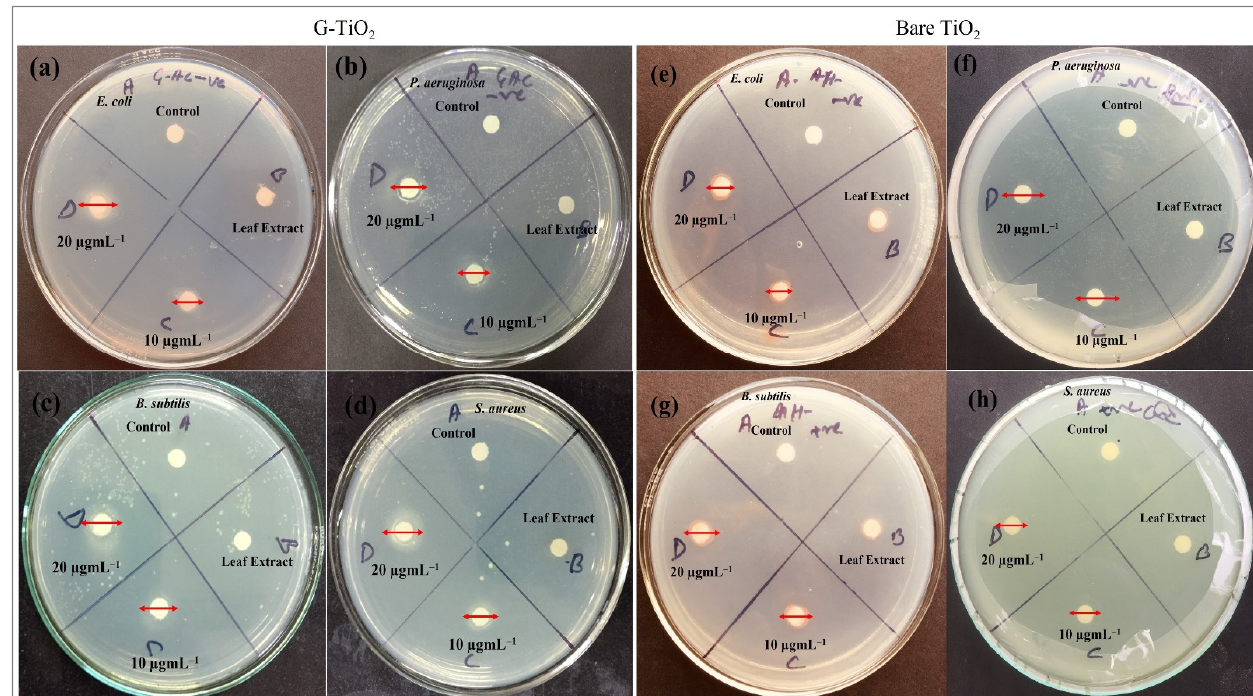
Figure 10. Assessment of antimicrobial efficiency of biosynthesized (G-TiO 2 ) and bare TiO 2 nanoparticles against Gram-negative ( a , b , e , f ) and Gram-positive bacteria ( c , d , g , h ) Reference 1. Ansari, A.; Siddiqui, V.U.; Rehman, W.U.; Akram, M.K.; Siddiqi, W.A.; Alosaimi, A.M.; Hussein, M.A.; Rafatullah, M. Green Synthesis of TiO 2 Nanoparticles Using Acorus calamus Leaf Extract and Evaluating Its Photocatalytic and In Vitro Antimicrobial Activity. Catalysts 2022 , 12, 181.